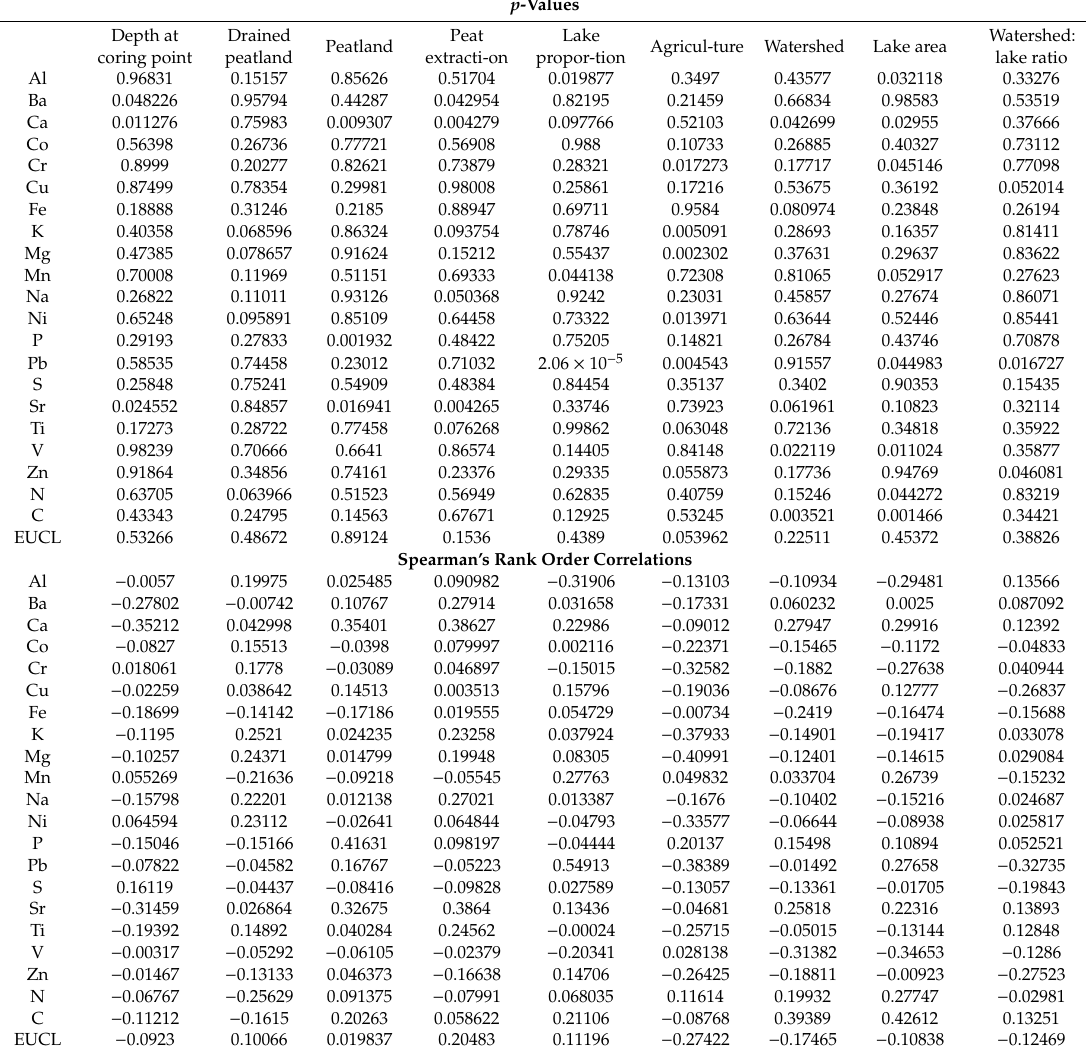
Table A3. Summary table of Euclidean distances ( p -values) between the bottom–top pairs calculated based on log-transformed chemical data presenting the overall chemical change and the summary table of Spearman’s rank order correlations presenting the bottom-to-top changes in individual elements (change in concentration relative to bottom concentration) related to the environmental variables (depth at coring point, drained peatlands (proportion of the catchment area), peatland (proportion of the catchment area), peat extraction (proportion of the catchment area), lake proportion (proportion of the catchment area), agriculture (proportion of the catchment area), watershed area (ha), lake area (ha), and watershed: lake